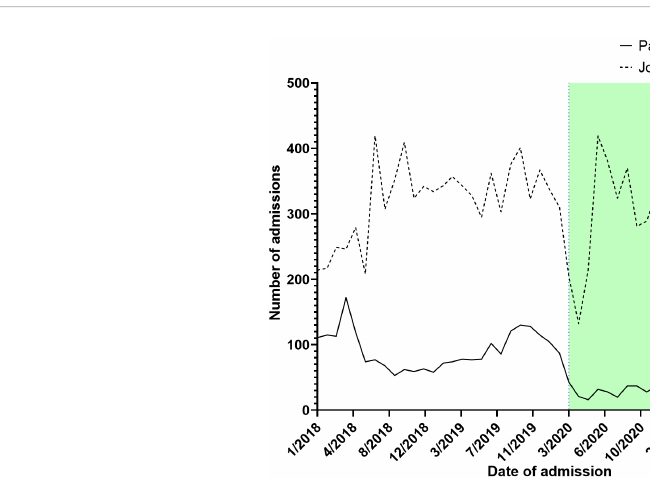
FIGURE 2 A parallel comparison between admission trends between Jordanian patients with cancer and patients from areas of con fl ict from 2018 to 2021.